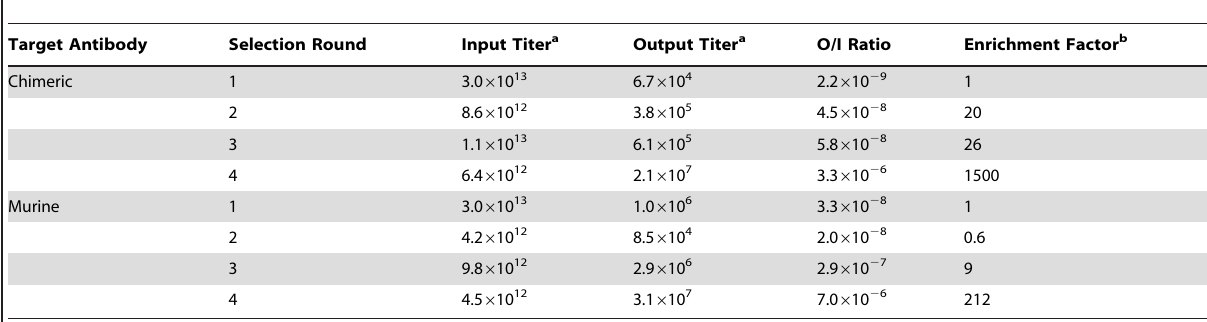
Table 1. Enrichment of phages by four consecutive rounds of